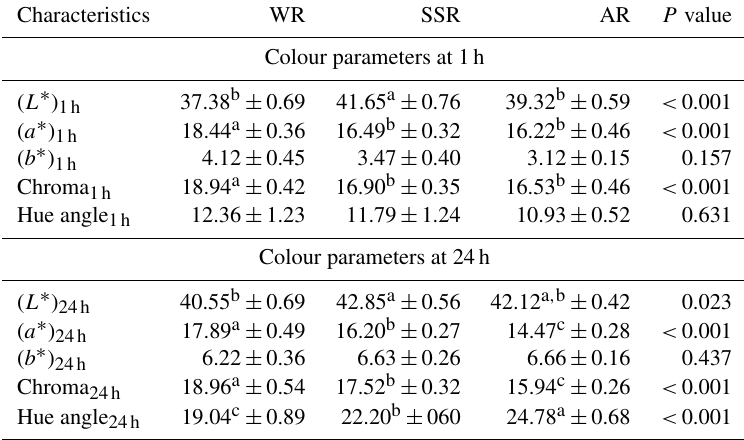
Table 5. Means ± for meat colour parameters of longissimus dorsi muscle of lambs reared in different